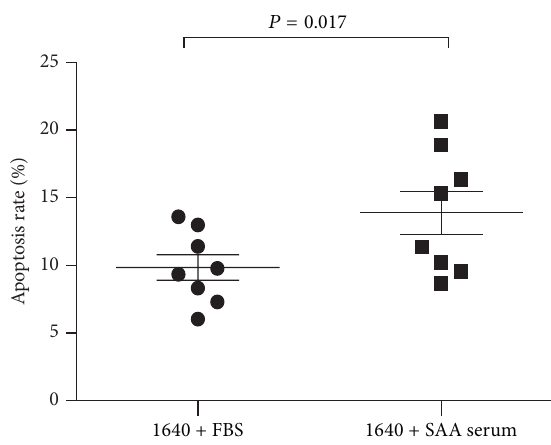
Figure 3: Relationship between hemoglobin, platelet count, abso- lute neutrophil count, and telomere length. HB: hemoglobin. PLT: platelet count. ANC: absolute neutrophil count.